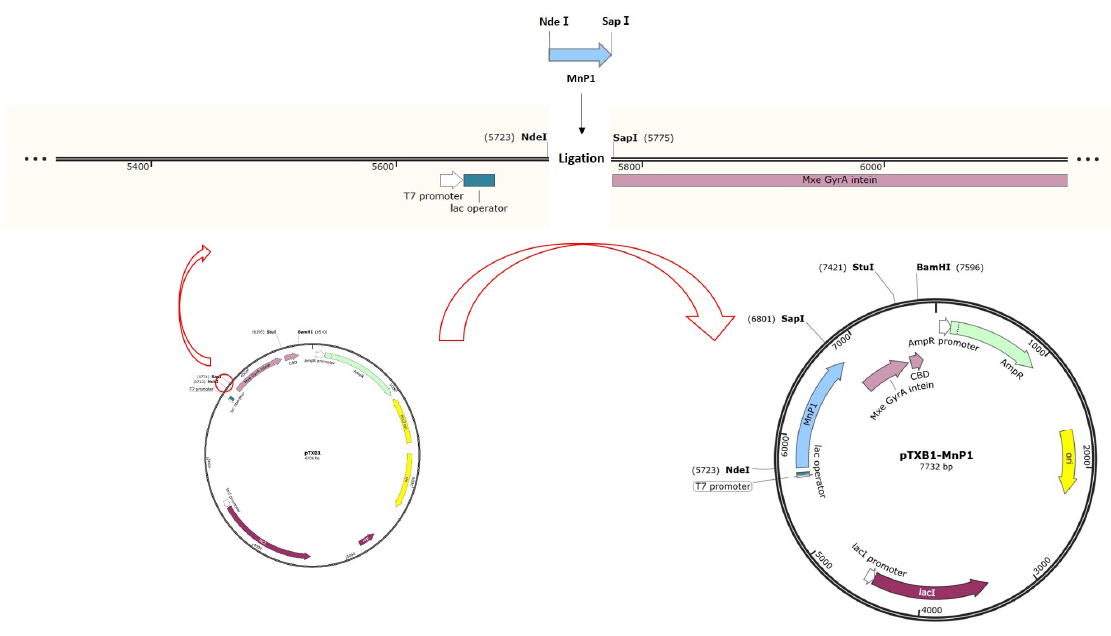
Figure 4. Schematic representation for the construction of the recombinant plasmid pTXB1-MnP1 [87]. Lee et al. [88] reported the heterologous expression of a novel MnP gene from Peniophora incarnata KUC8836 in Saccharomyces cerevisiae and observed that this MnP was secreted more efficiently into the culture medium in this case than in wild-type S. cere- visiae . Xu et al. [89] cloned the Ganoderma lucidum MnP gene ( GluMnP1 ) and transferred it